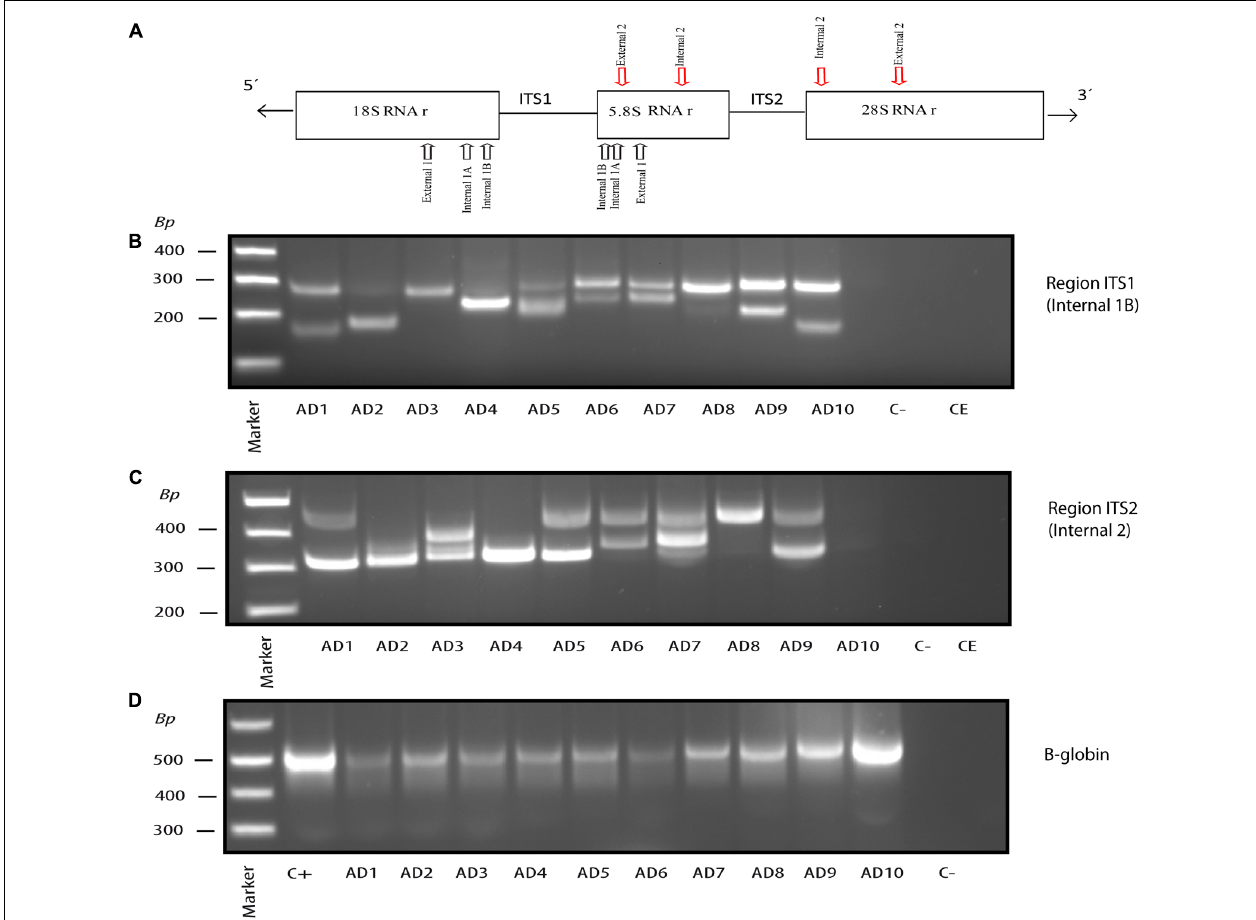
FIGURE 2 | Nested PCR of fungal DNA from AD frozen tissue. PCR analysis was carried out as described (see section “Materials and Methods”). Schematic representation of fungal rRNA genes (18S, 5.8S and 28S rRNA) and the ITS-1 and ITS-2 regions, including location of the primers employed for the different nested PCRs: primers External 1 employed in the first PCR; primers Internal 1A and Internal 1B employed in the second PCR to amplify ITS-1; primers Internal 2 employed in the second PCR to amplify ITS-2 (A) . Agarose gel electrophoresis of the DNA fragments amplified by nested PCR using DNA extracted from frozen FC tissue. PCR analysis of ten AD patients using primers Internal 1B to amplify the ITS-1 region (B) . PCR analysis to amplify the ITS-2 region from 10 AD patients using primers Internal 2 (C) . PCR analysis of DNA extracted from the samples tested in (B,C) using human β -globin oligonucleotide primers (D) . Control–, PCR without DNA. CE, Control of DNA extraction without DNA. C+, DNA extracted from HeLa